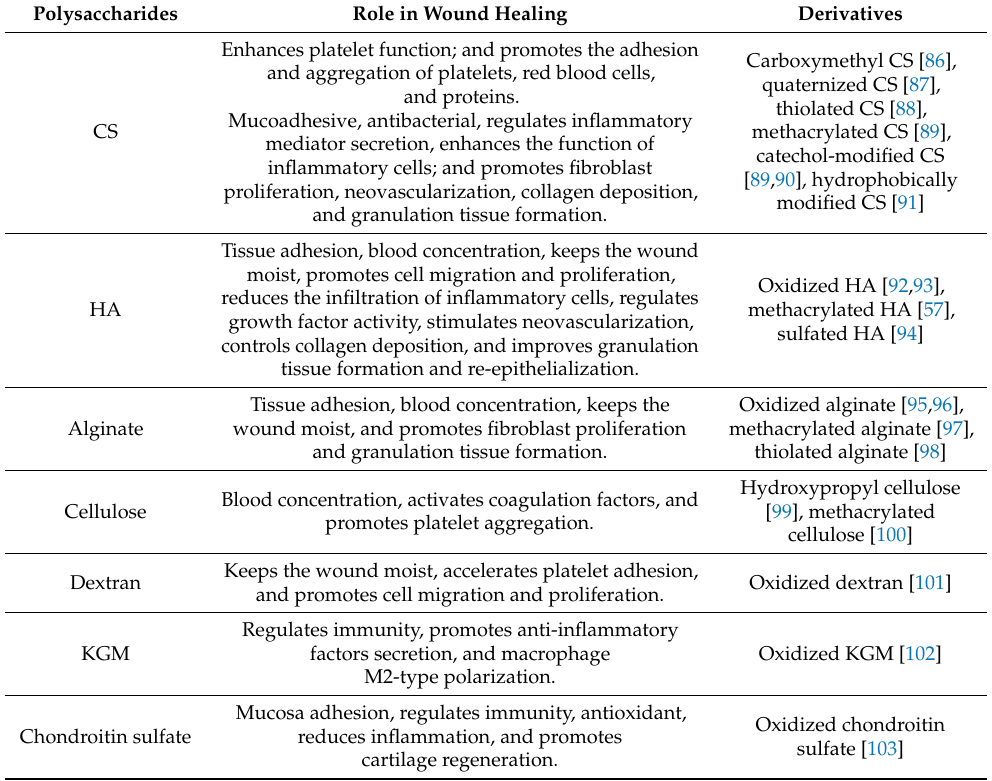
Table 1. Role in wound healing and derivatives of various